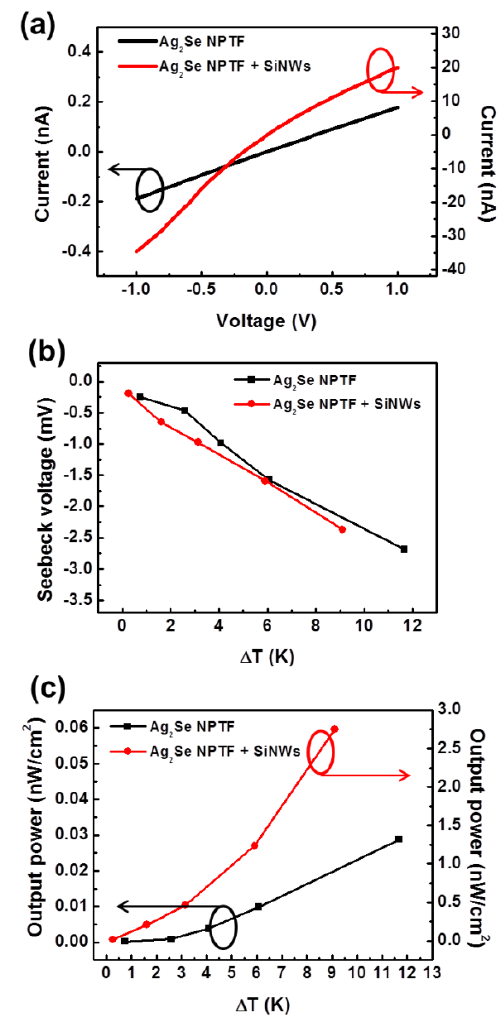
Figure 6. ( a ) Current–voltage characteristics, ( b ) Seebeck voltage, and ( c ) output power as a function of temperature difference for the Ag 2 Se NPTF alone and the Ag 2 Se NPTF embedded with SiNWs.